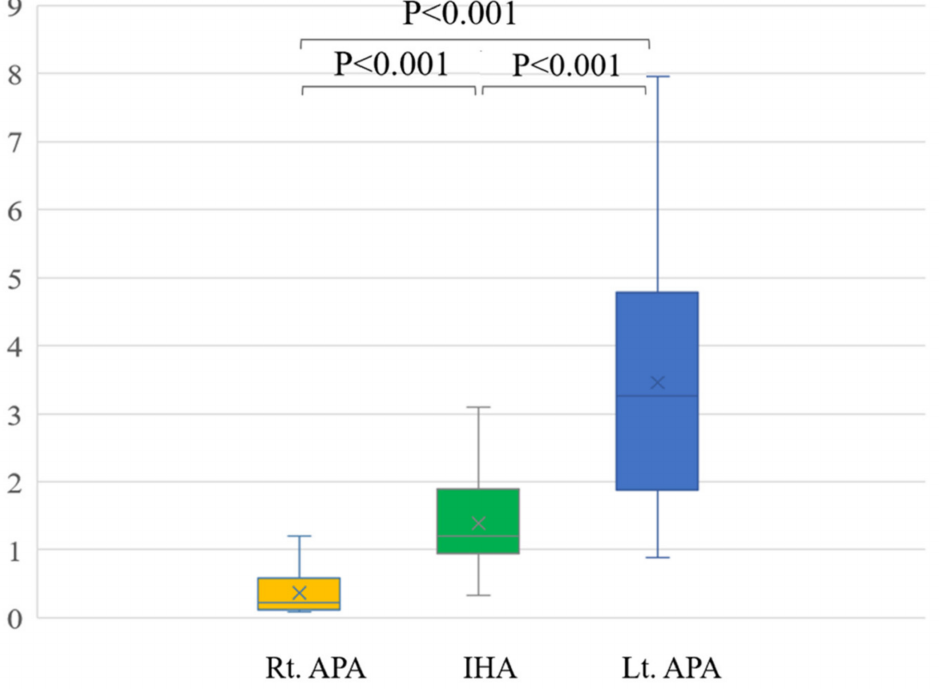
Figure 4. The modified LI of right APA (0.4 ± 0.4) was significantly lower than those of IHA (1.4 ± 0.7) ( p < 0.001) and left APA (3.5 ± 2.0) ( p < 0.001). The modified LI of left APA was significantly higher than those of IHA ( p < 0.001) and right APA ( p <